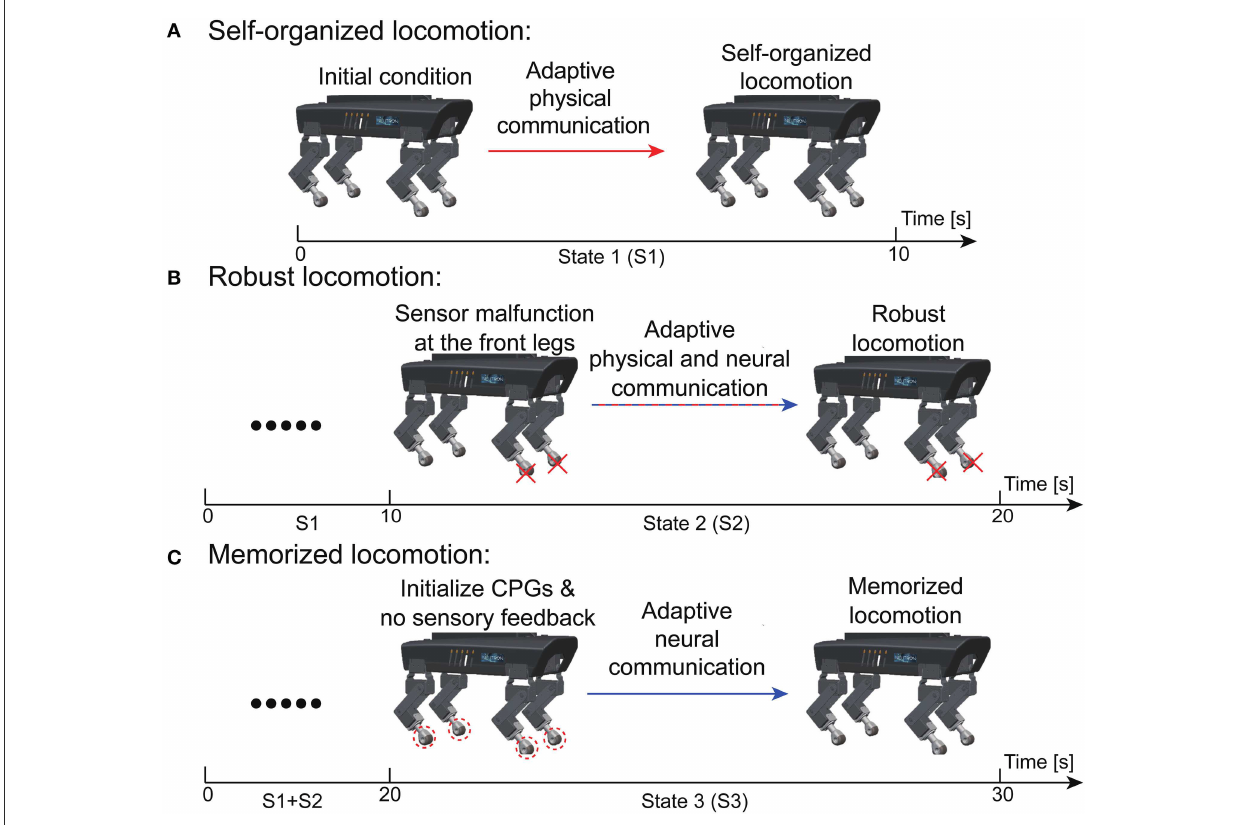
FIGURE9 Experiment setup to evaluate the performance of the adaptive neural control (see text for details). (A) Self-organized locomotion. (B) Robust locomotion. (C) Memorized